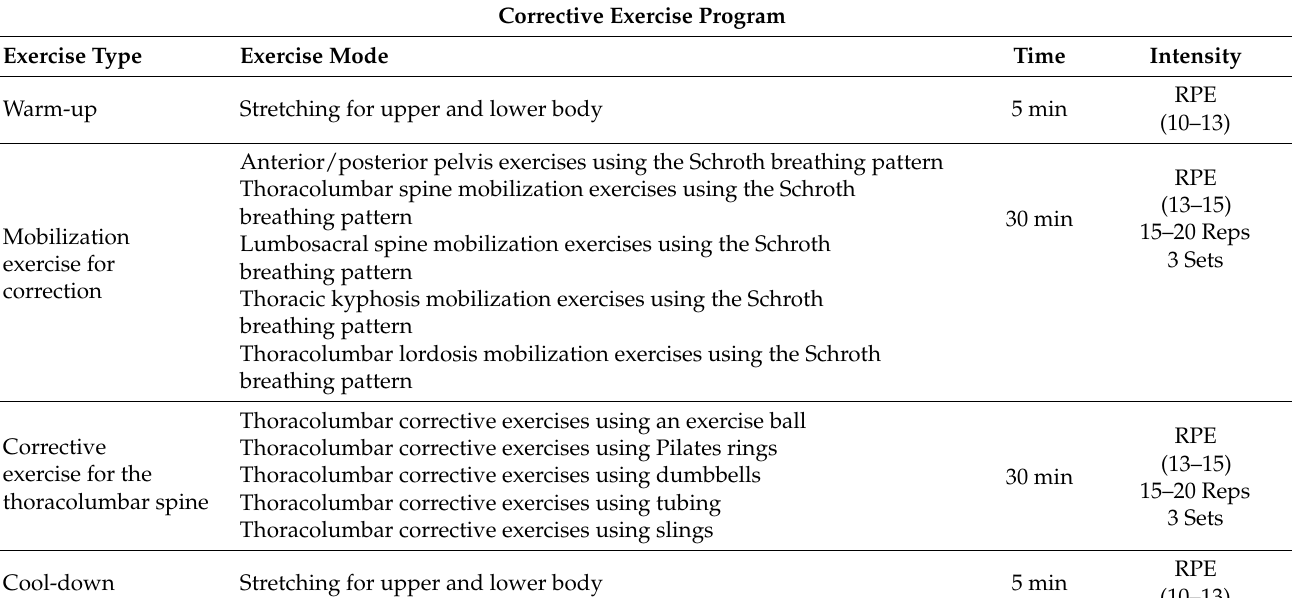
Table 1. The corrective exercise